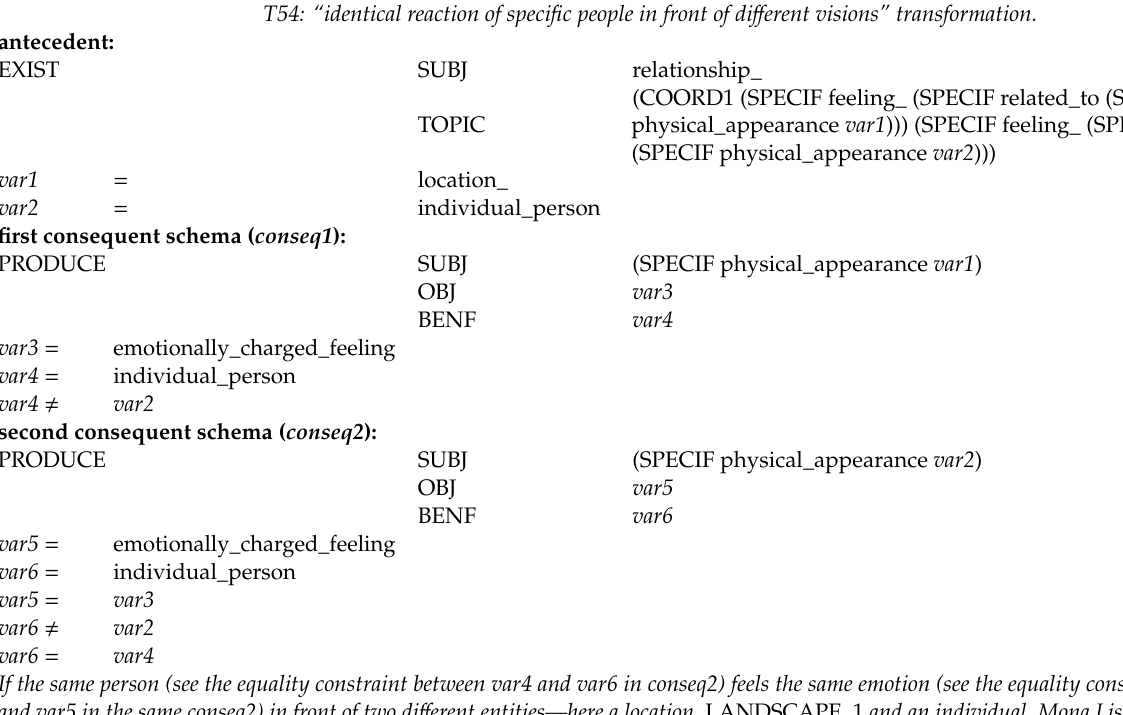
Table 6. A transformation rule